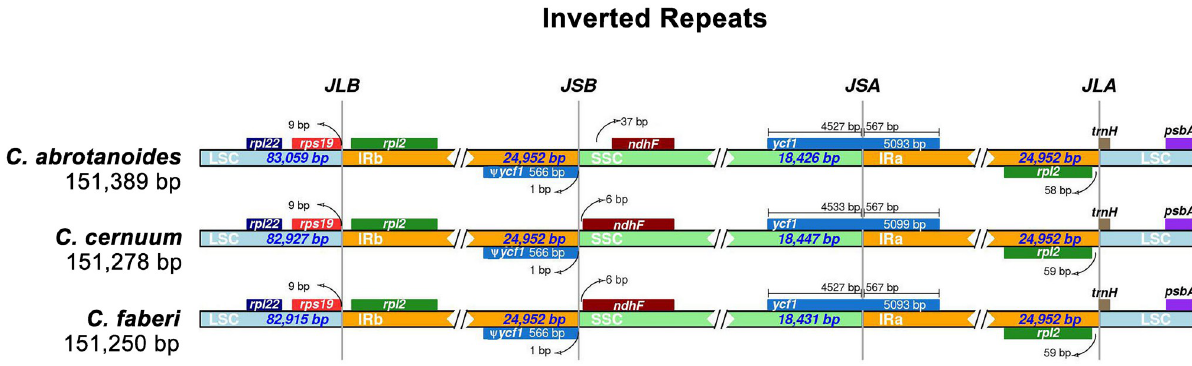
Fig 5. Comparative analysis of the LSC, IRs, and SSC boundary regions of the cp genomes of three Carpesium species.